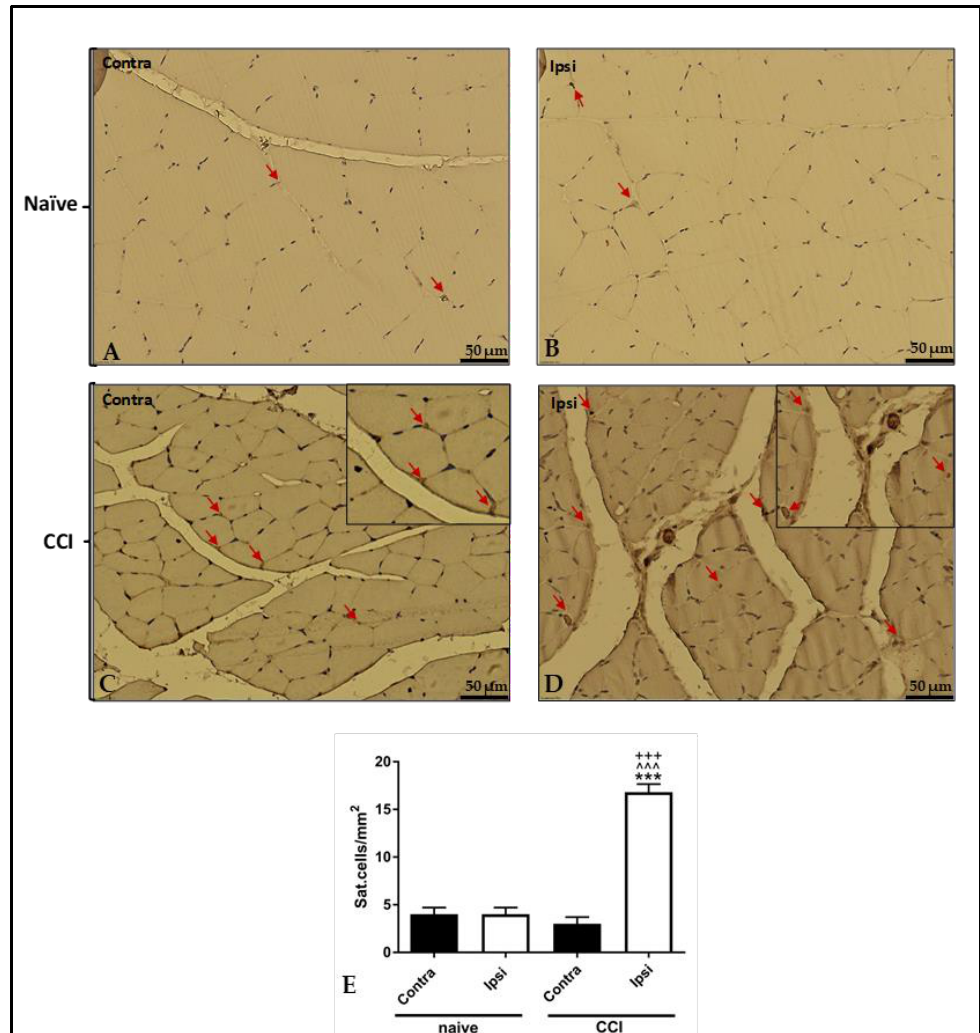
Figure 9. Results of immunohistochemical staining. Representative images of Pax-7 immunostaining in the ipsilateral CCI GC ( D ) show a higher number of Pax-7 positive satellite cells than that observed in the contralateral muscle ( C ) and in the contralateral ( A ) and ipsilateral ( B ) GC of naïve rats, as shown also in graph ( E ). Arrow = satellite cells. Analysis of immunohistochemical staining intensity in contralateral and ipsilateral gastrocnemius. Sections tissue was independently counted by three researchers and was averaged and depicted. The results are expressed as mean ± S.E.M. ***: p < 0.001 vs. contra CCI; ^^^: p < 0.001 vs. contralateral naϊve ; +++: p < 0.001 vs. ipsilateral naϊve.